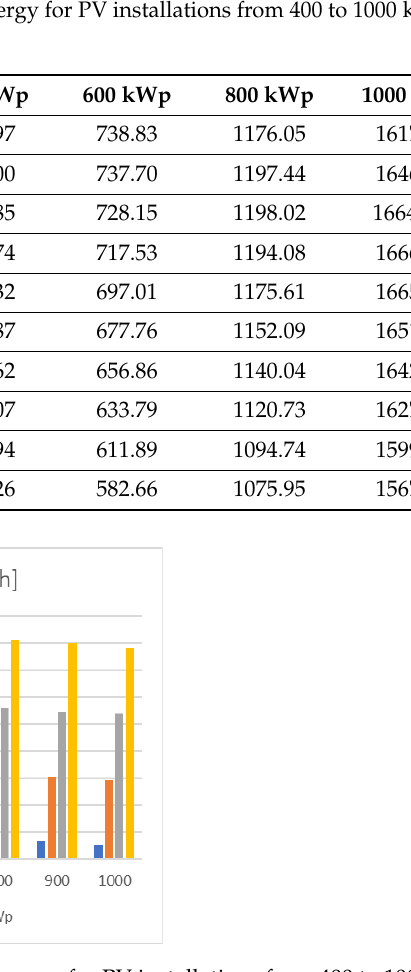
Figure 6. Average daily amounts of not captured energy for PV installations from 400 to 1000 kWp for different battery energies from 100 to 1000 kWh.